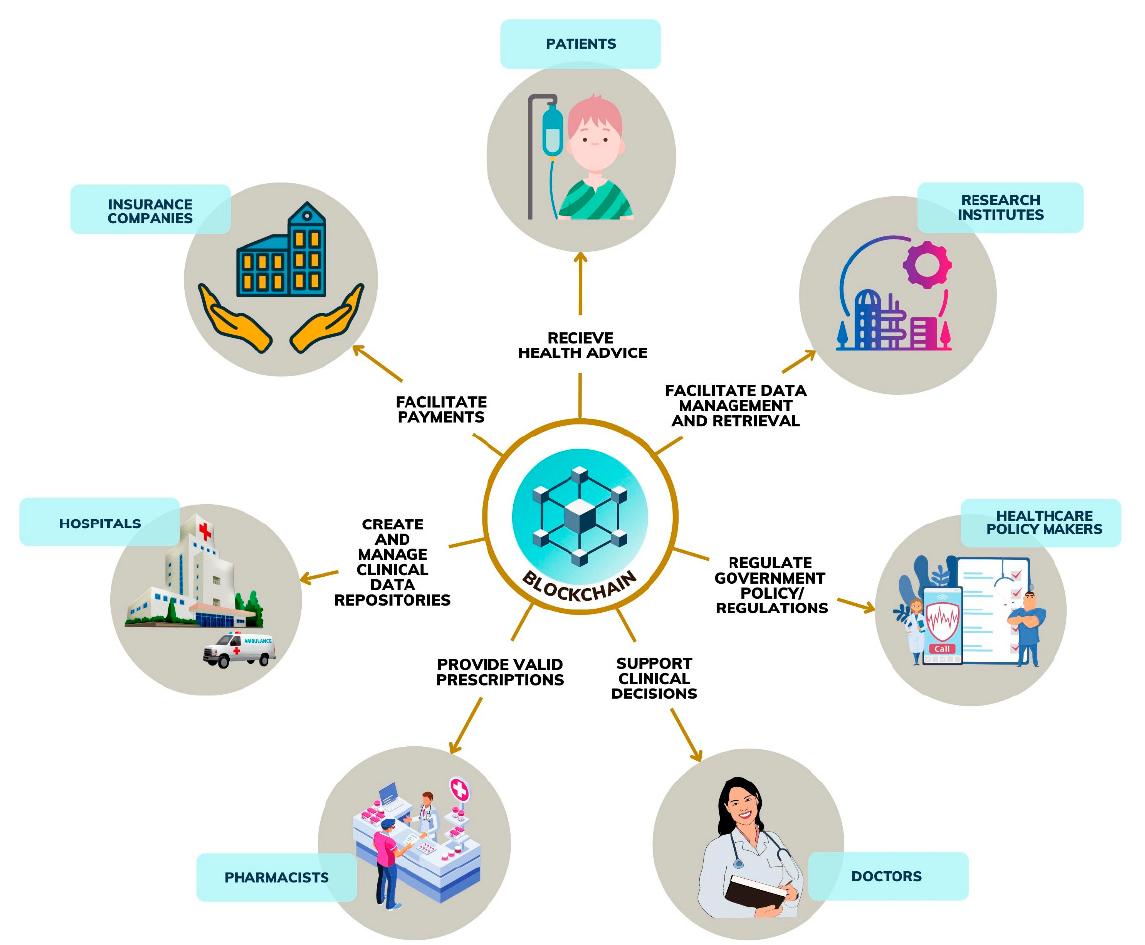
Figure 13. A blockchain-based approach to IoT-supported postanalytical dissemination of results in clinical laboratories.